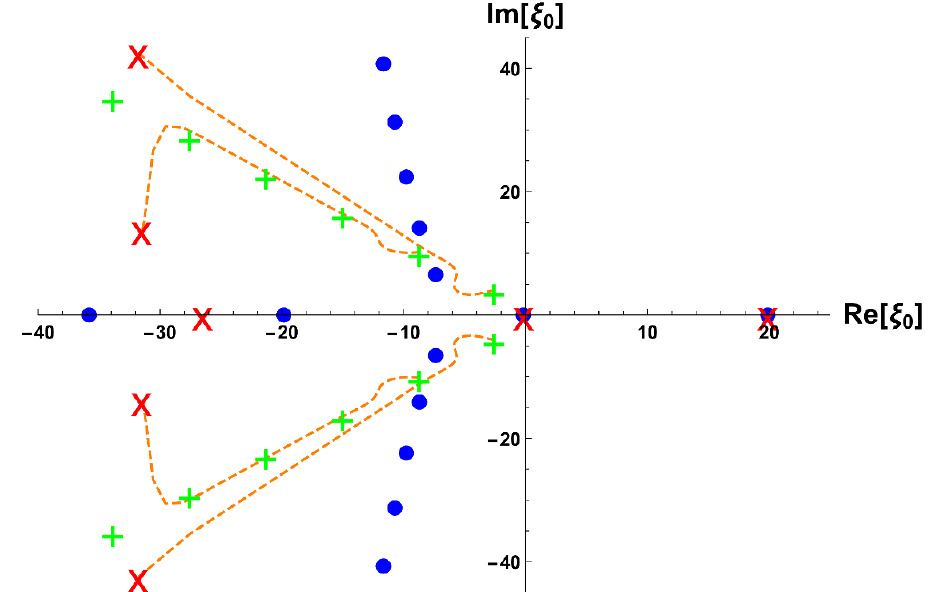
Figure 17 . Borel plane singularities (solid circles) and the QNM frequencies (crosses) at s = 0 (cid:12) T (cid:12) with T (cid:25) 1 . Green crosses represent QNM frequencies at (cid:22) = 0, red crosses represent (cid:12) (cid:22) 10 (cid:22) crit ;s =0 QNM frequencies at corresponding T . Orange lines represent the ‘(cid:13)ow’ of the QNM frequencies as (cid:22) (cid:22) changes from